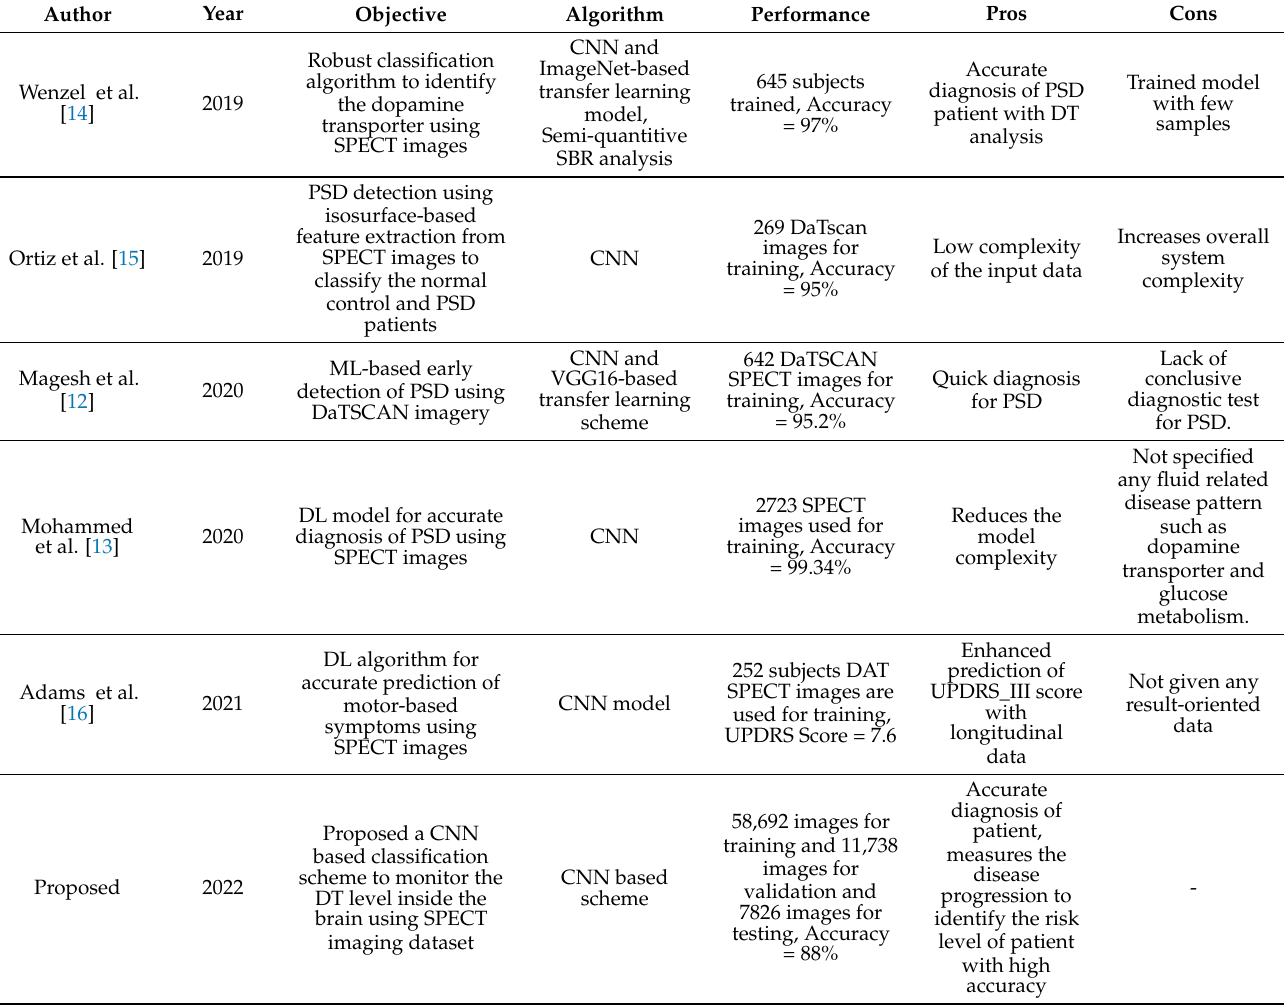
Table 1. State-of-art-work presented with consideration of SPECT